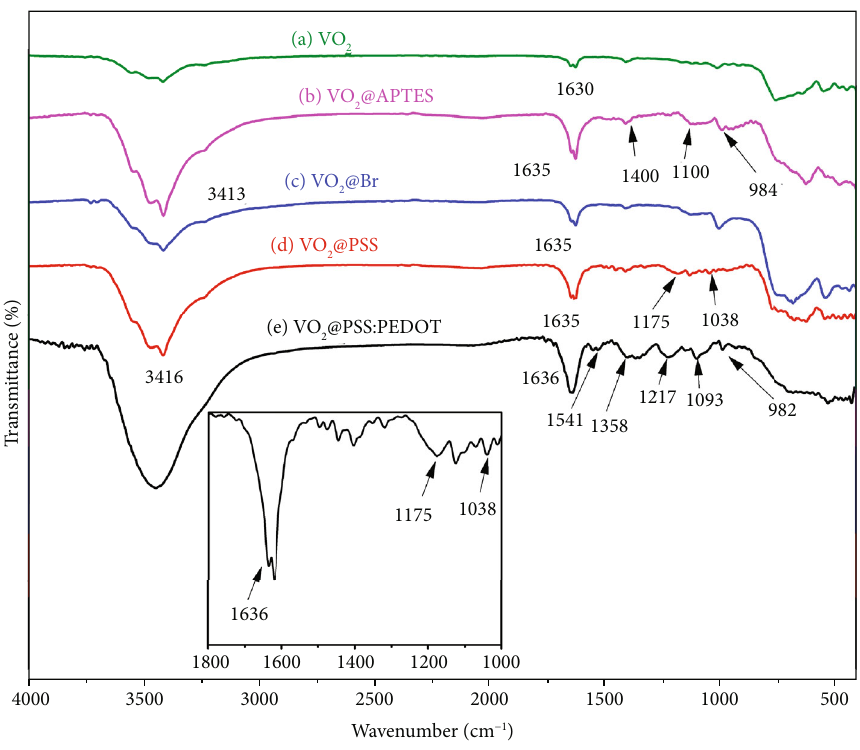
Figure 2: FT-IR spectra of various VO (e) VO @PSS :PEDOT. 2